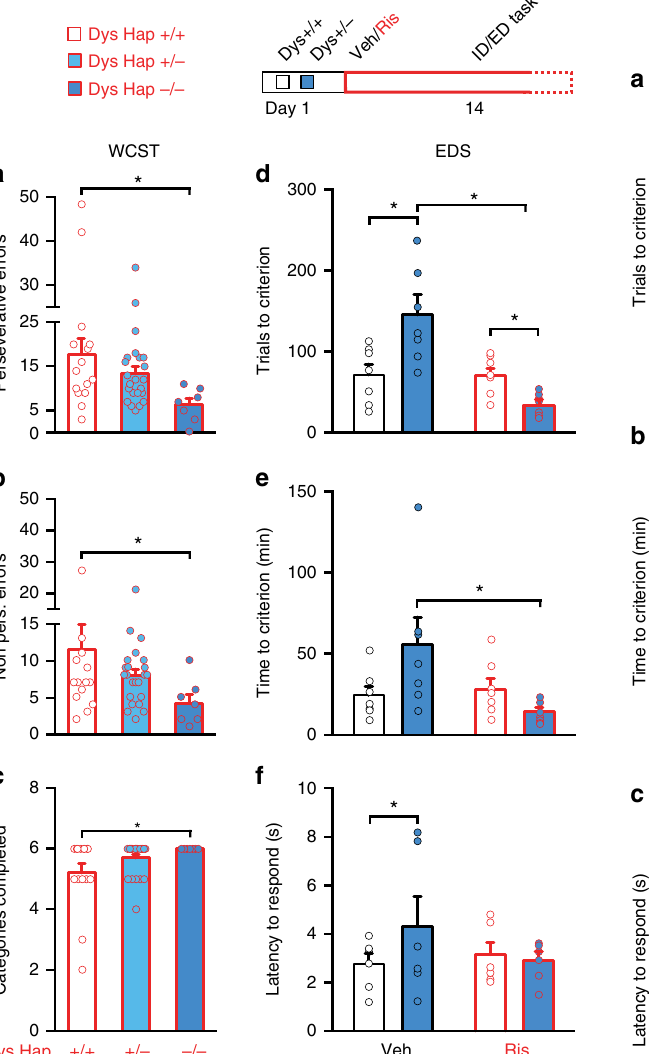
Fig. 2 Antipsychotic drug treatment improves executive functions selectively in subjects with reduced dysbindin-1 expression. a – c Among patients with schizophrenia after their fi rst episode of psychosis, those with reduced dysbindin-1 expression (Dys Hap − / − , blue dark bar) made a less perseverative errors (one-way ANOVA, F (2, 34) = 3.59, p < 0.05; n = 45), b non-perseverative errors (one-way ANOVA, F (2, 34) = 3.59, p < 0.05) and c passed more categories (one-way ANOVA, F (2, 34) = 3.15, p = 0.05) on the WCST than those with Dys Hap + / + (white bar). d , e Dys + / − mice (dark blue bar) after risperidone treatment (Ris in red) required d fewer trials (two-way ANOVA, genotype× treatment, F (1, 24) = 13.40, p < 0.005, n = 7 per group) and e less time (two-way ANOVA, genotype × treatment, F = 5.69, p < 0.05) than Dys + / + (white bar) to complete the EDS of (1, 24) the ID/ED task. f Dys + / − mice (dark blue bar) needed more time to make a response (latency to respond) in the EDS than vehicle-treated (white bar) wild-type controls needed ( t = 2.54, df = 15.60, p < 0.05). However, we did not fi nd a treatment effect (two-way ANOVA, genotype × treatment, F (1, = 1.56, p = 0.20). Error bars represent S.E.M. * p < 20) because D2 receptors exist in two different splicing isoforms 47 , we also assessed whether the dysbindin-antipsychotics interaction might differently impact the D2L and D2S isoforms. Chronic treatment with risperidone increased the D2S/D2L ratio in the mPFC of Dys + / − but not Dys + / + mice (Fig. 5b). To investigate